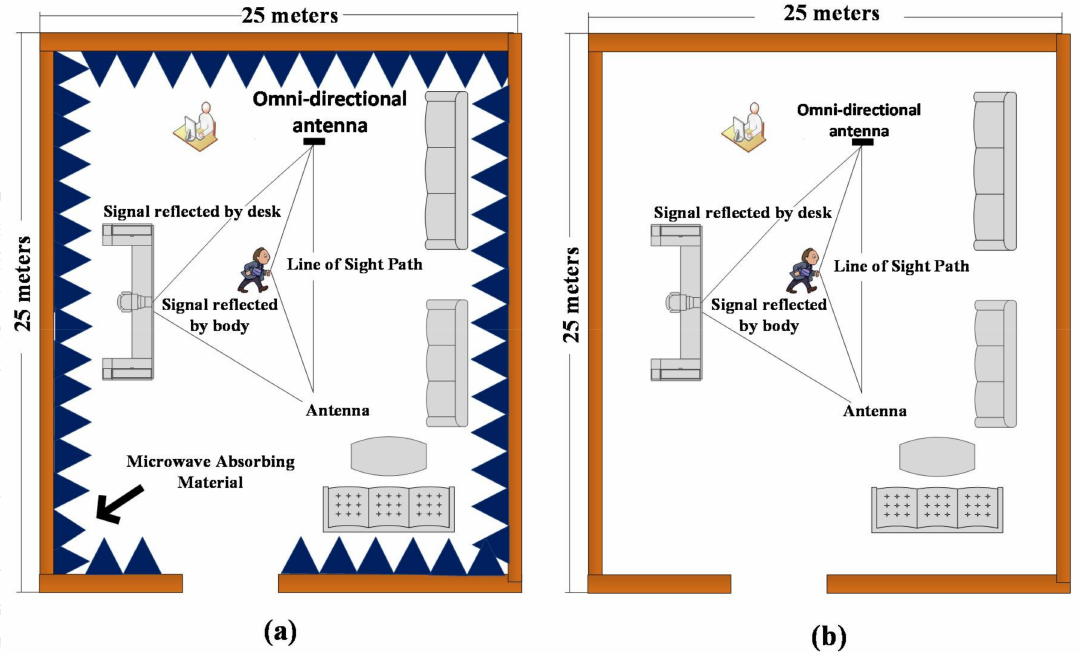
Figure 1. Experiment design for detection sleep attacks. ( a ) Experimental setup with the microwave absorbing material. ( b ) Experimental setup without microwave absorbing